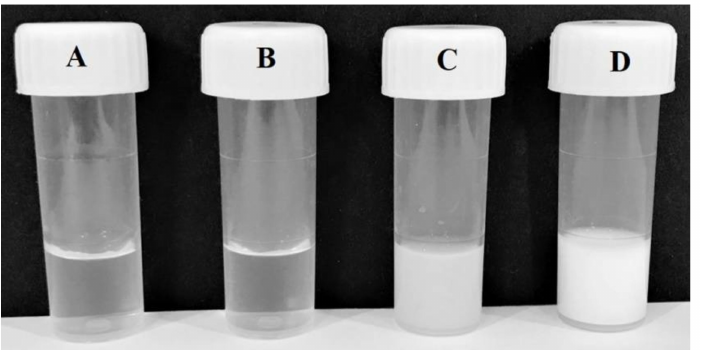
Figure 1. Image showing chemical reaction steps for tamoxifen (TAM)- and resveratrol (RES)-loaded liquid crystalline nanoparticles (LCNPs) and layer-by-layer (LbL) nanoparticle-coated TAM/RES- LCNPs. The color change was observed within the reaction: ( A ) TAM, ( B ) RES, ( C ) preparation step 1, ( D ) preparation step